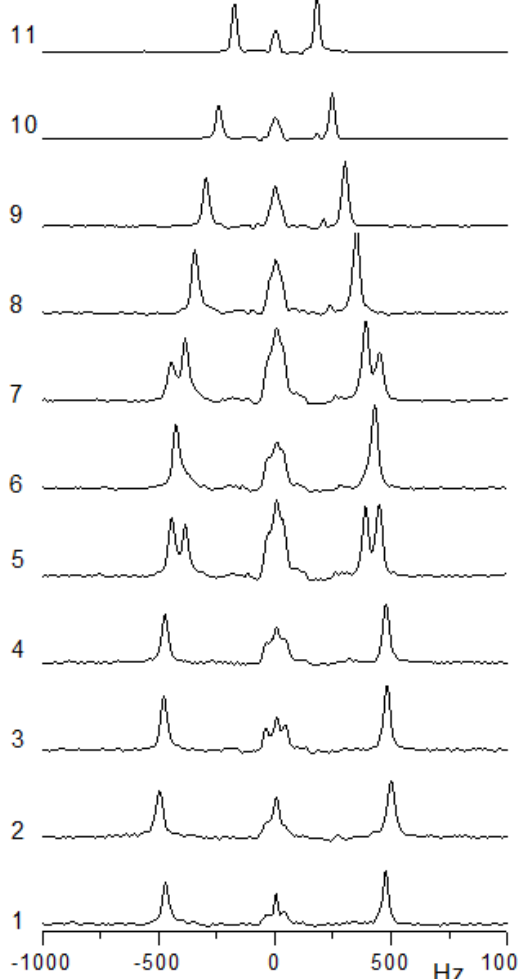
Figure 2. Dipolar cross-sections in two-dimensional proton detected / encoded local field (PDLF) spectrum of C 12 mimBF 4 sample in smectic A phase at 38 °C for the methylene carbons 1–11 of the alkyl chain. Signals of carbons 5 and 7 exhibit partial overlap.